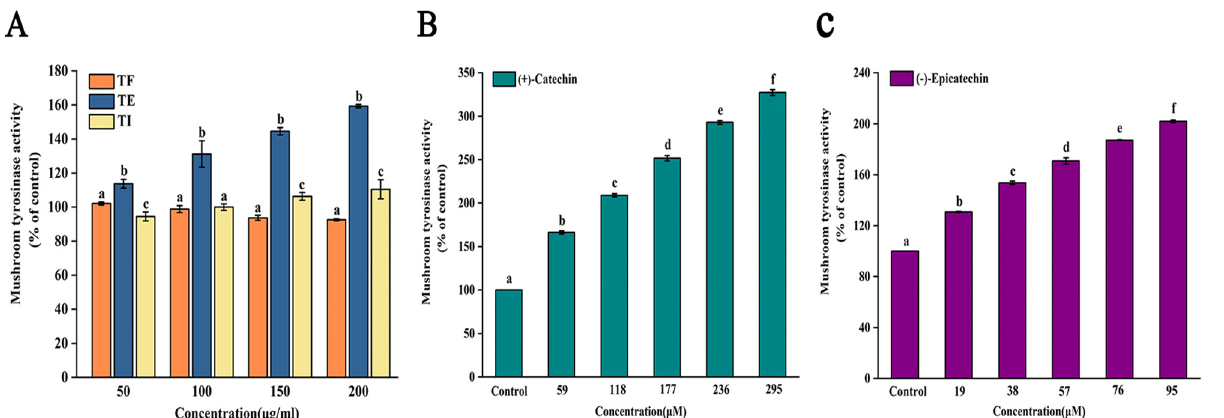
Figure 4. Activities effect of three polyphenolic extracts ( A ) and main components ((+) ‐ catechin ( B ) and ( − ) ‐ epicatechin ( C )) from Prinsepia utilis Royle seed shell toward tyrosinase. Values are shown as the mean ± SD (n = 3). TF, the free polyphenols; TE, the esterified polyphenols; TI, the insoluble bound polyphenols. The different letters indicated significant differences ( p < 0.05).